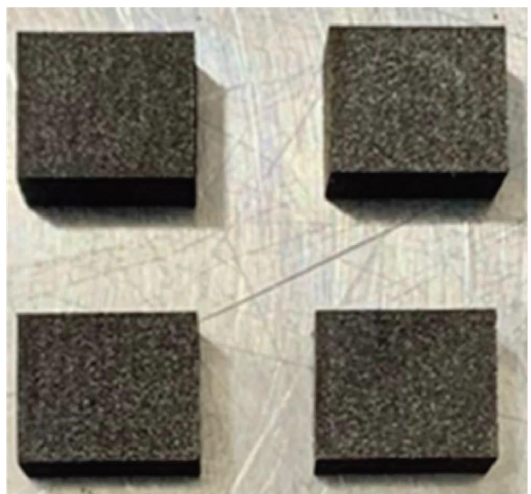
Figure 3: Dimensions of SLM as-manufacturing specimens (10 × 10 × 10mm 3 ).